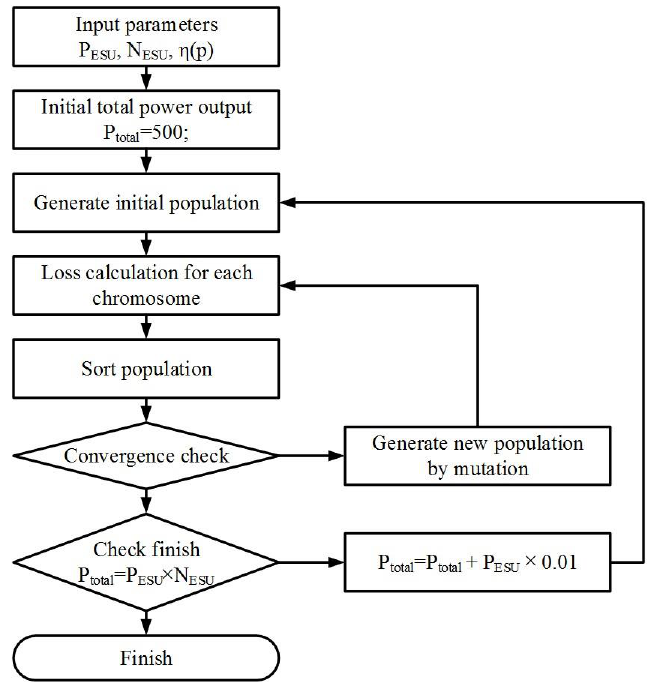
Figure 7. Genetic algorithm flowchart for lookup table generation.